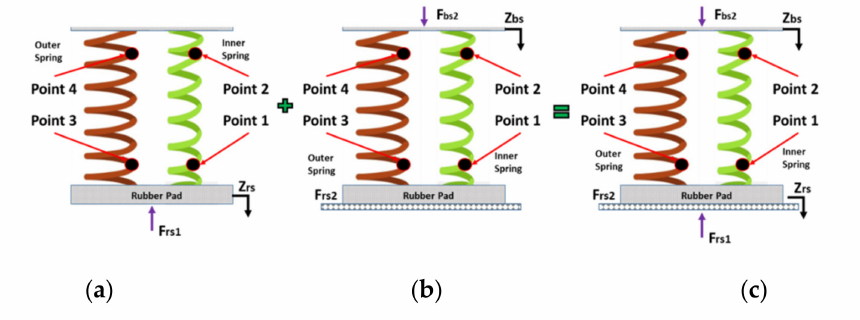
Figure 8. Stress calculation with force input for the ( a ) bottom of the spring set, ( b ) top of the spring set and the ( c ) combined model based on